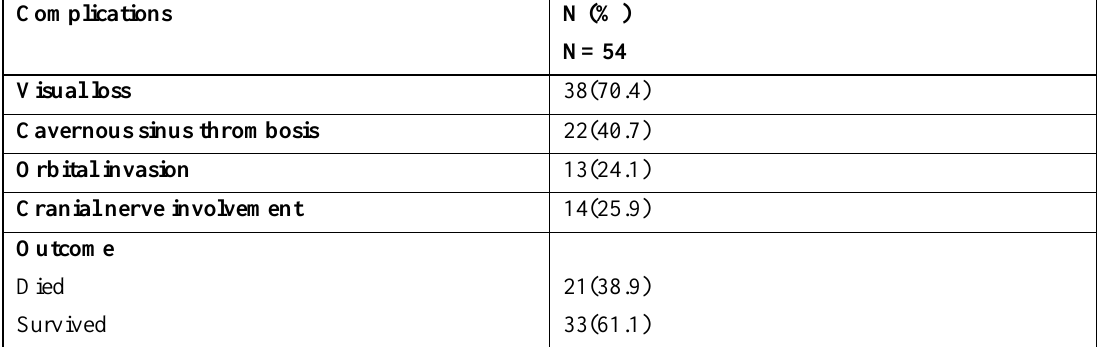
Table 2. Complications, clinical extension and outcomes for the studied AIFRS